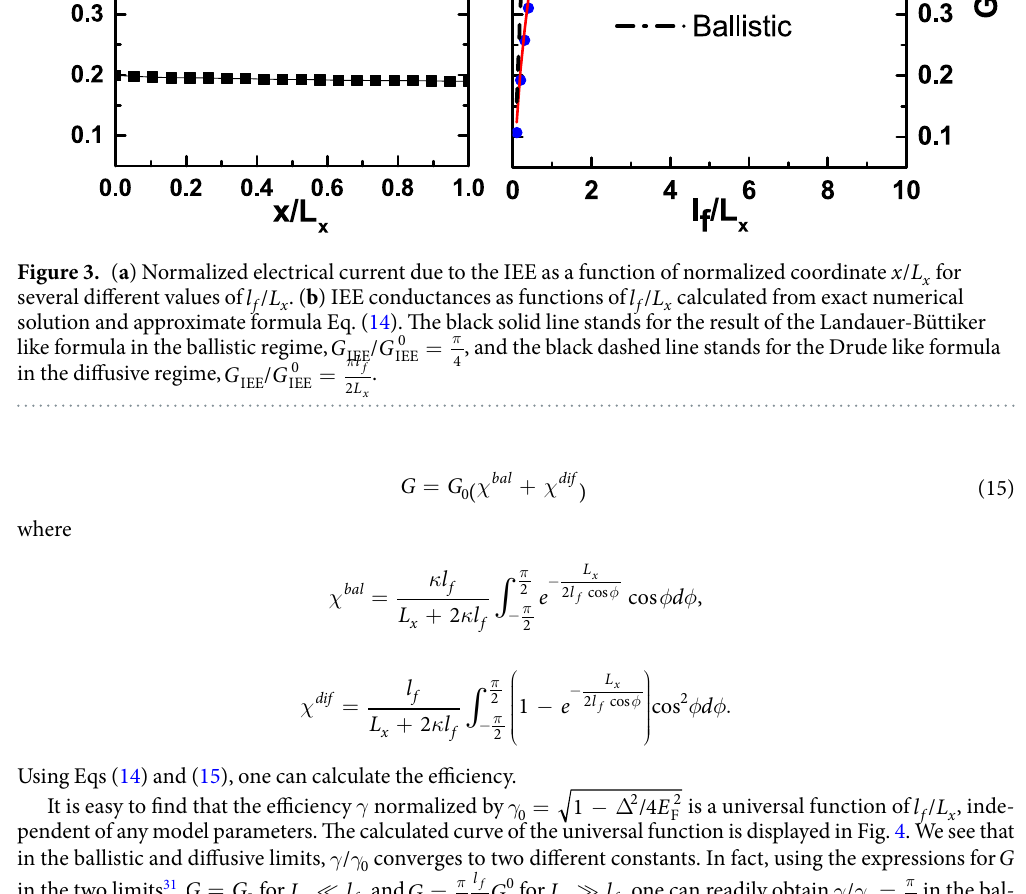
, and as 4 0 , the electrons x f